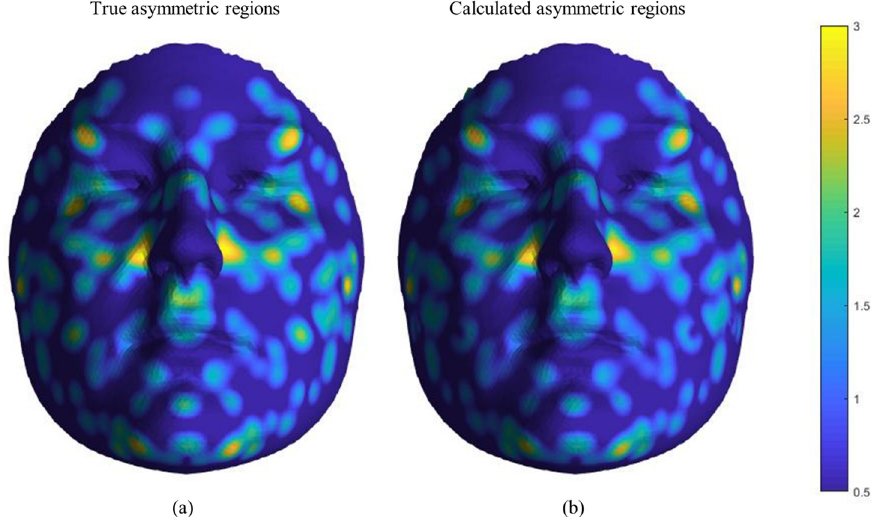
Fig 6. Asymmetry heat-map of a sample simulated face. (a) and (b) show the true and the calculated